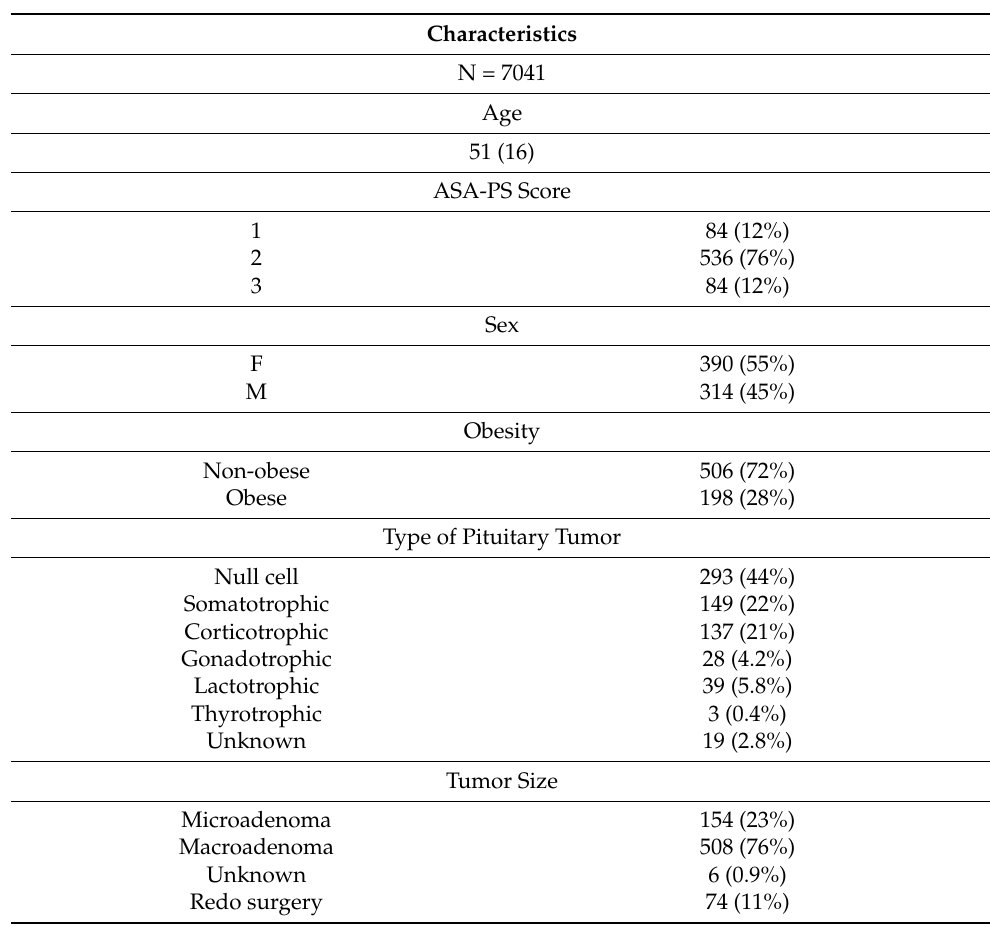
Table 1. Preoperative patients’